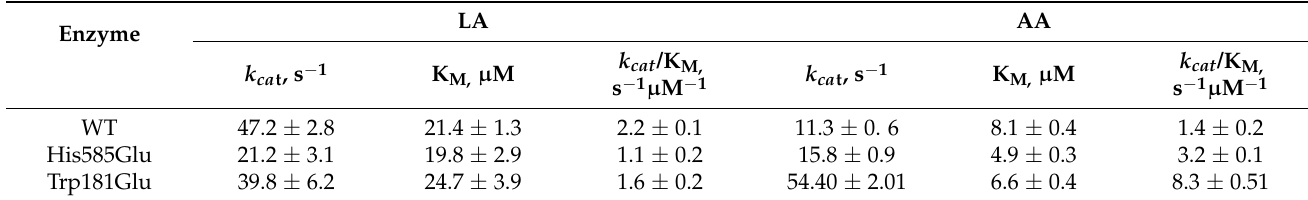
Table 1. Catalytic activities of rabbit wild-type ALOX15 and selected